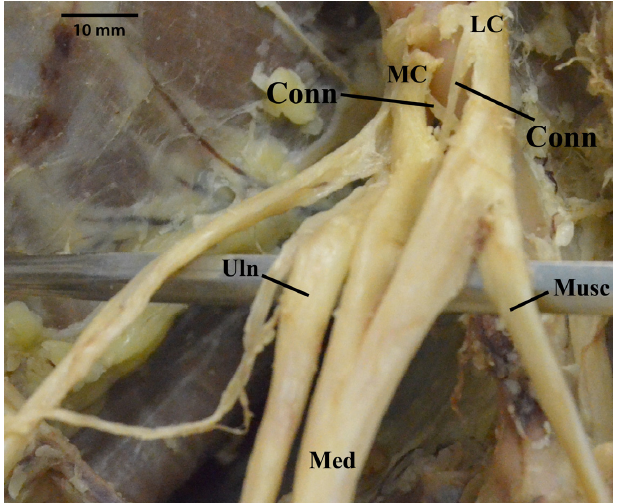
Figure 12. Photograph demonstrating a crisscrossing connection between the medial and lateral cords proximal to the “M”. Abbreviations: Conn = connections between lateral cord and medial cord; LC = lateral cord; MC = medial cord; Med = median nerve; Musc = musculocutaneous nerve; Uln = ulnar nerve.